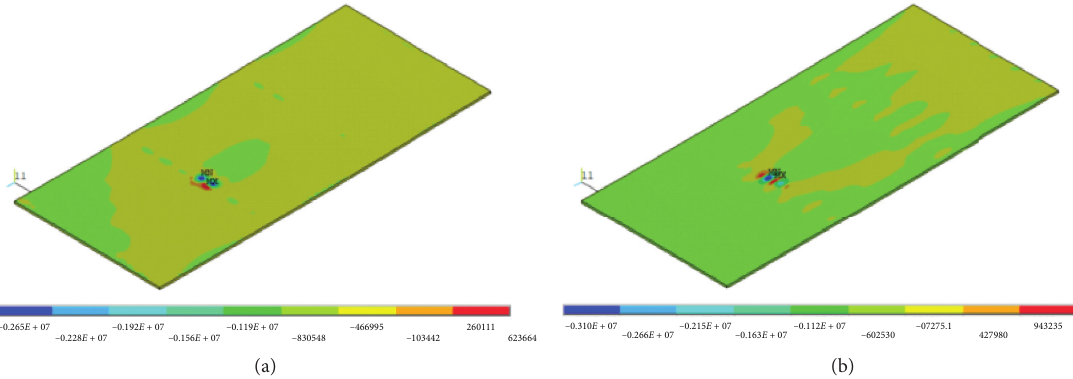
Figure 17: The shear stress distribution diagram of the midspan pavement under wheel load under full-bridge action. (a) Interlaminar longitudinal shear stress. (b) Interlaminar transverse shear stress.